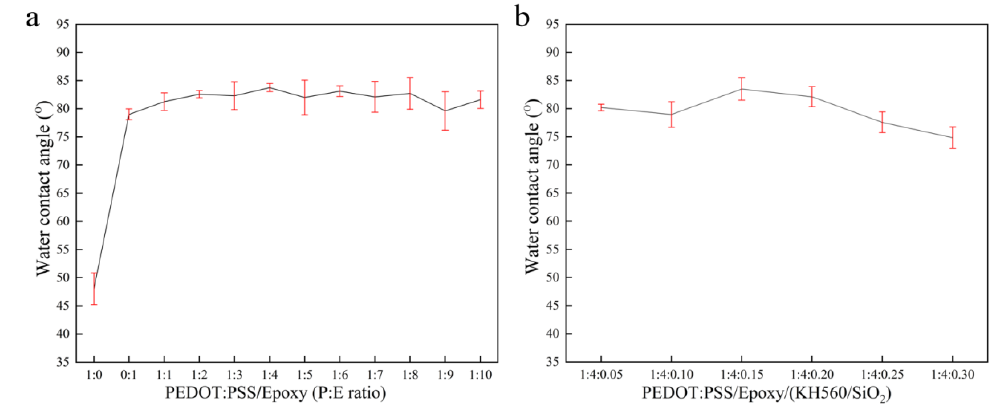
Figure 11. WCAs of PEDOT:PSS/epoxy ( a ) and PEDOT:PSS/epoxy/(KH560/SiO 2 ) ( b ) composite coat- ings.